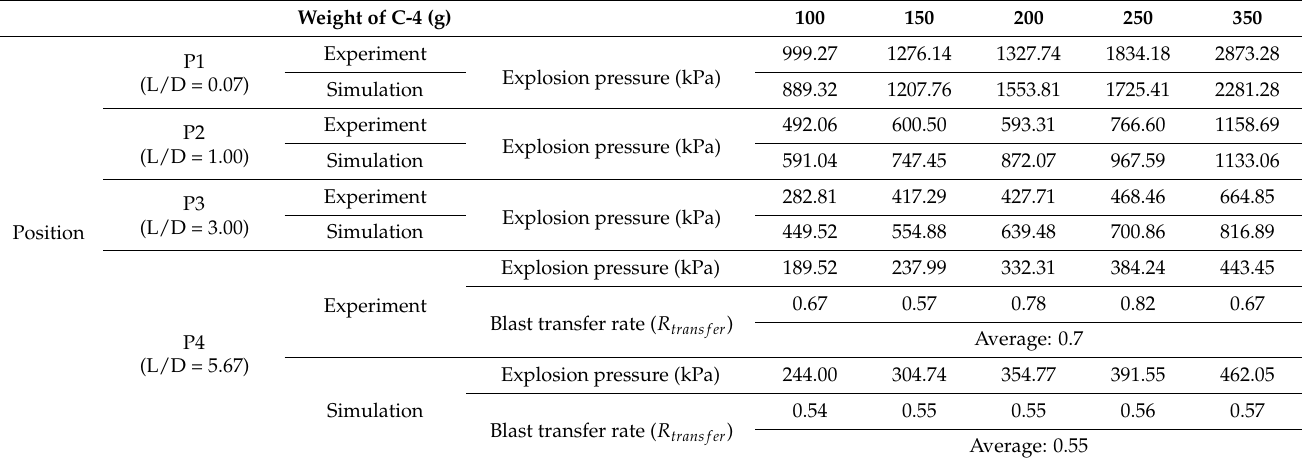
Table 1. Comparison of experiment and numerical results of linear tunnel with expansion chamber. Weight of C-4